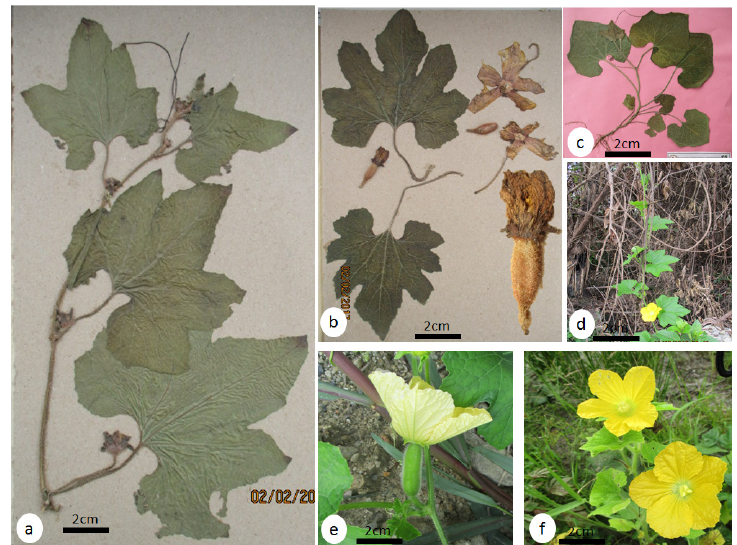
Fig. 1. Vegetative and reproductive parts of B. hispida : a – c. voucher specimens-UPH/V/1264, a & b. mature plants, c. seedling, d. plant habit, e. female flower and f. male flower